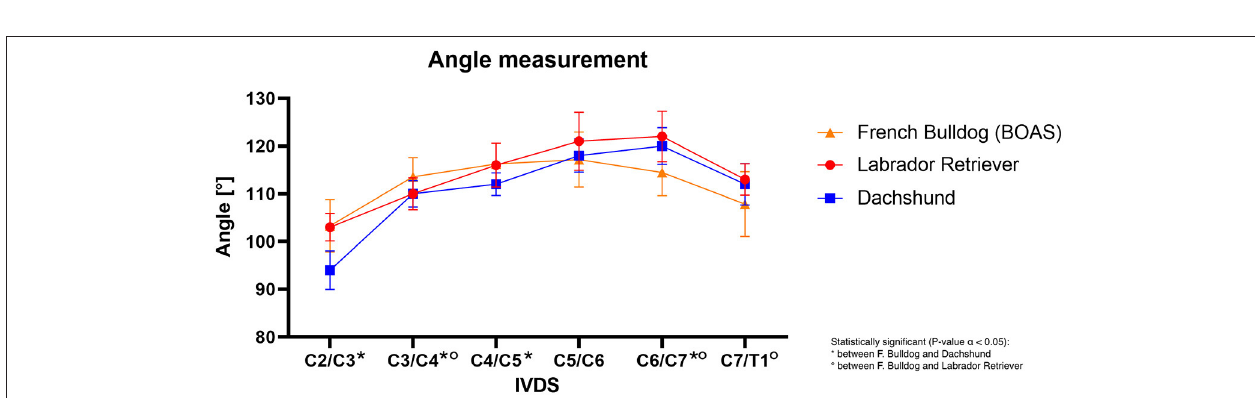
FIGURE 11 | Line graph showing mean angles of intervertebral disk to vertebral body at each IVDS of the cervical spine from C2/C3 to C7/T1 in French bulldogs (orange line), Labrador retriever (red line), and dachshund (blue line).